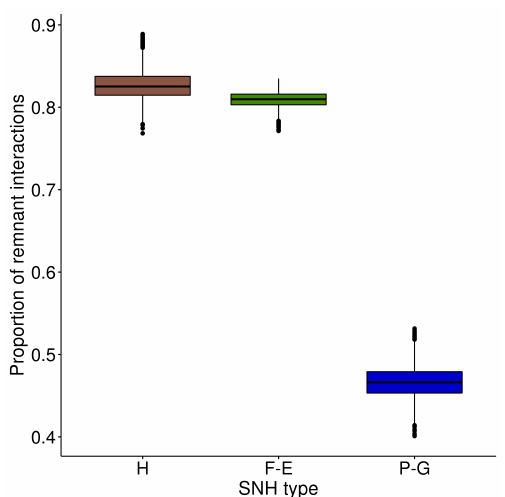
Figure 8. Impact of the removal of species of each type of SNH (H: hedgerows, F-E: forest edges and P-G: permanent grasslands) on the proportion of bee–pollen interactions remaining in the network. Boxplots represent median value, first and third quartile. Mean is equal to